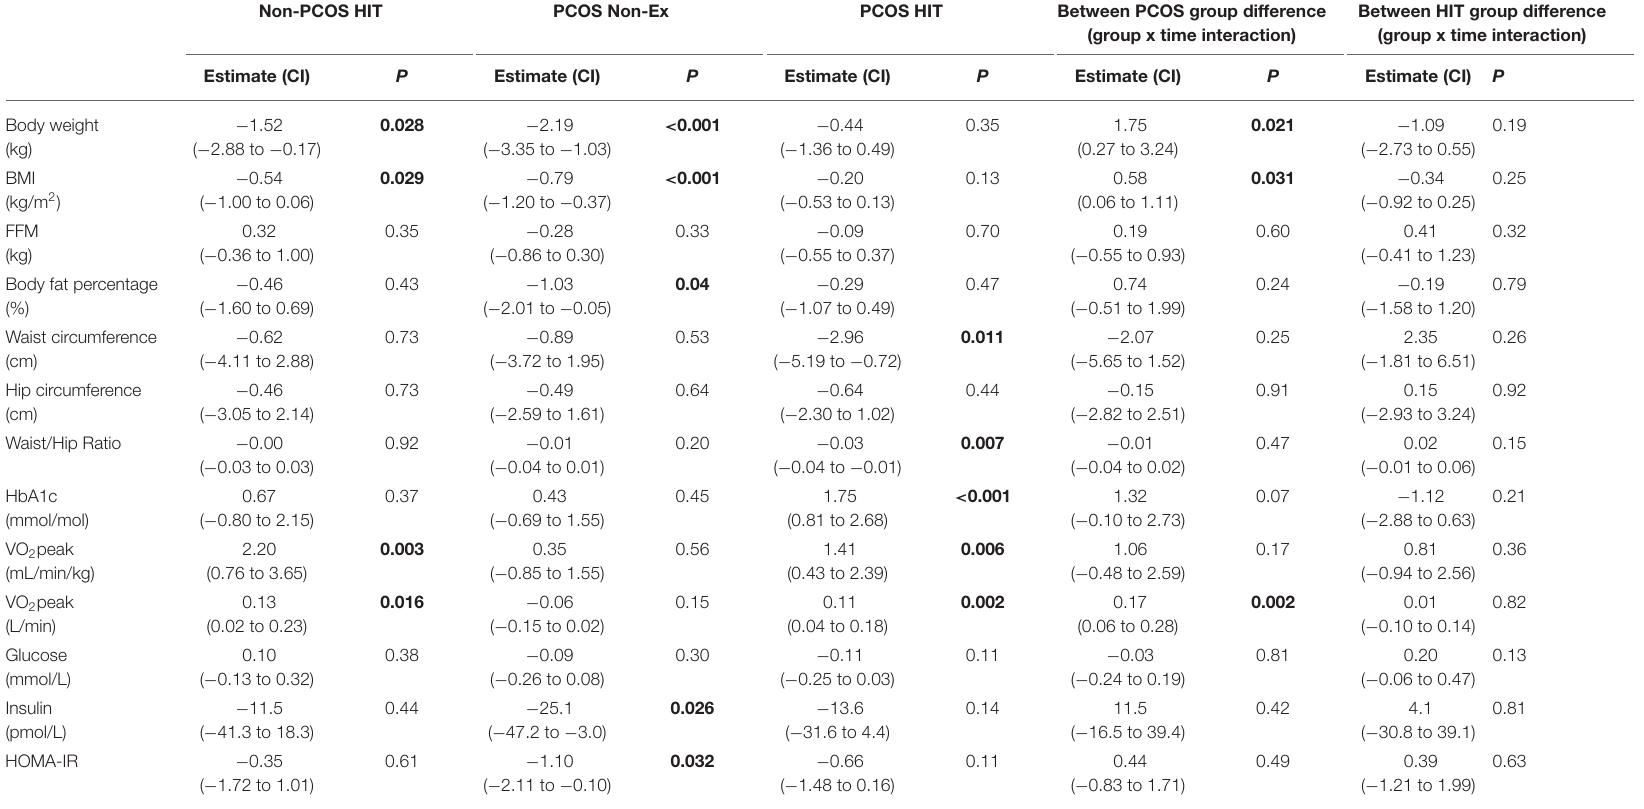
Estimated mean difference from baseline values(95% confidence interval) based on linear mixed models. PCOS, Polycystic ovary syndrome; CI, Confidence interval; BMI, body mass index; FFM, Fat free mass; VO 2 peak, peak oxygen uptake; HOMA-IR, Homeostatic model assessment of insulin resistance. Statistically significant P-values are in